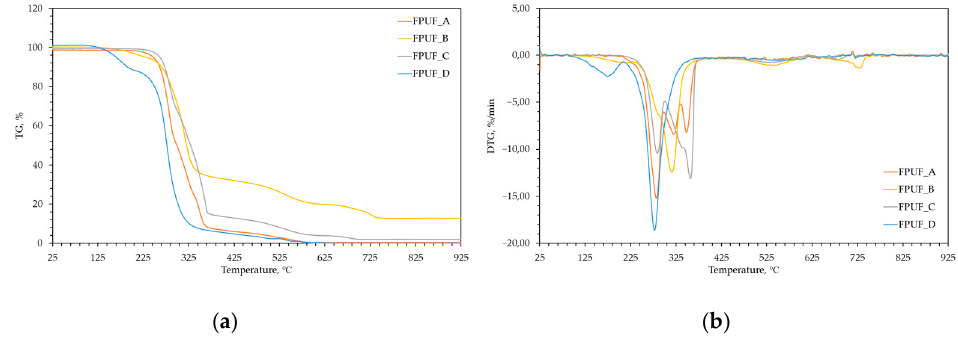
Figure 1. TGA ( a ) and DTG ( b ) curves of tested polyurethane foams. Table 2. Thermal properties of TGA and DTG analysis of tested flexible polyurethane